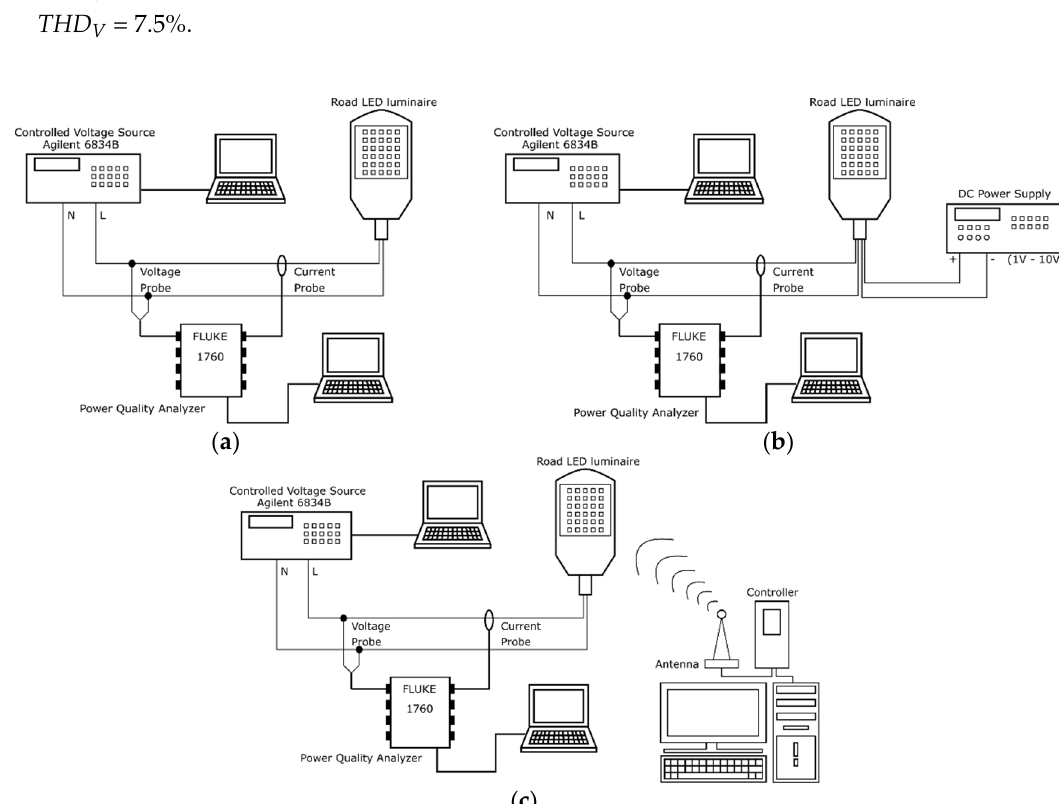
Figure 1. Measurement diagrams used to: ( a ) measure the RMS (Root Mean Square) value and deformation of the supply voltage, ( b ) measure the control characteristics of the light-emitting diode (LED4) luminaire, ( c ) measure the control characteristics of the LED3 luminaire.